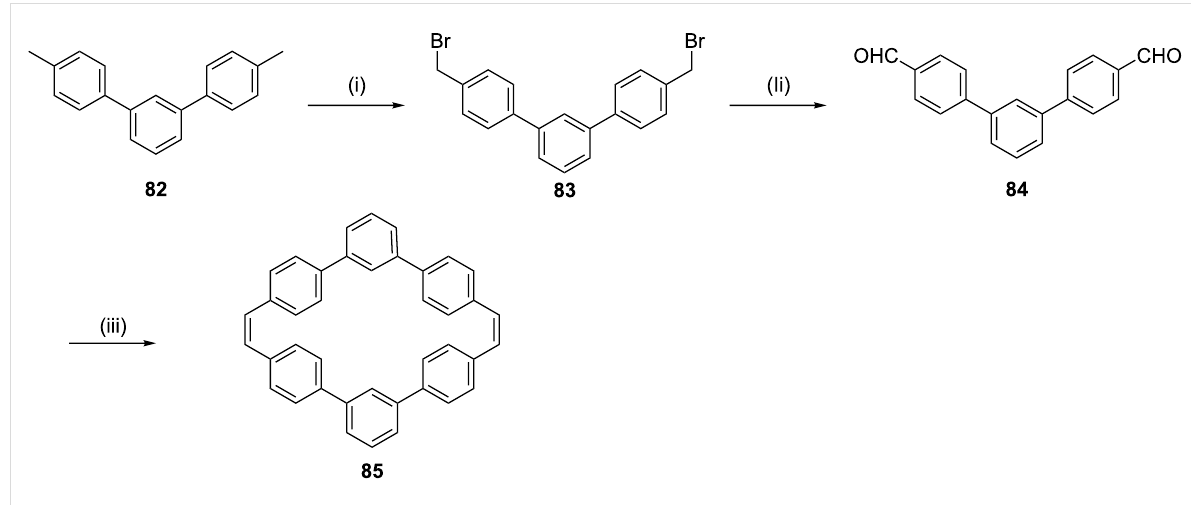
ments indicated the intramolecular electronic